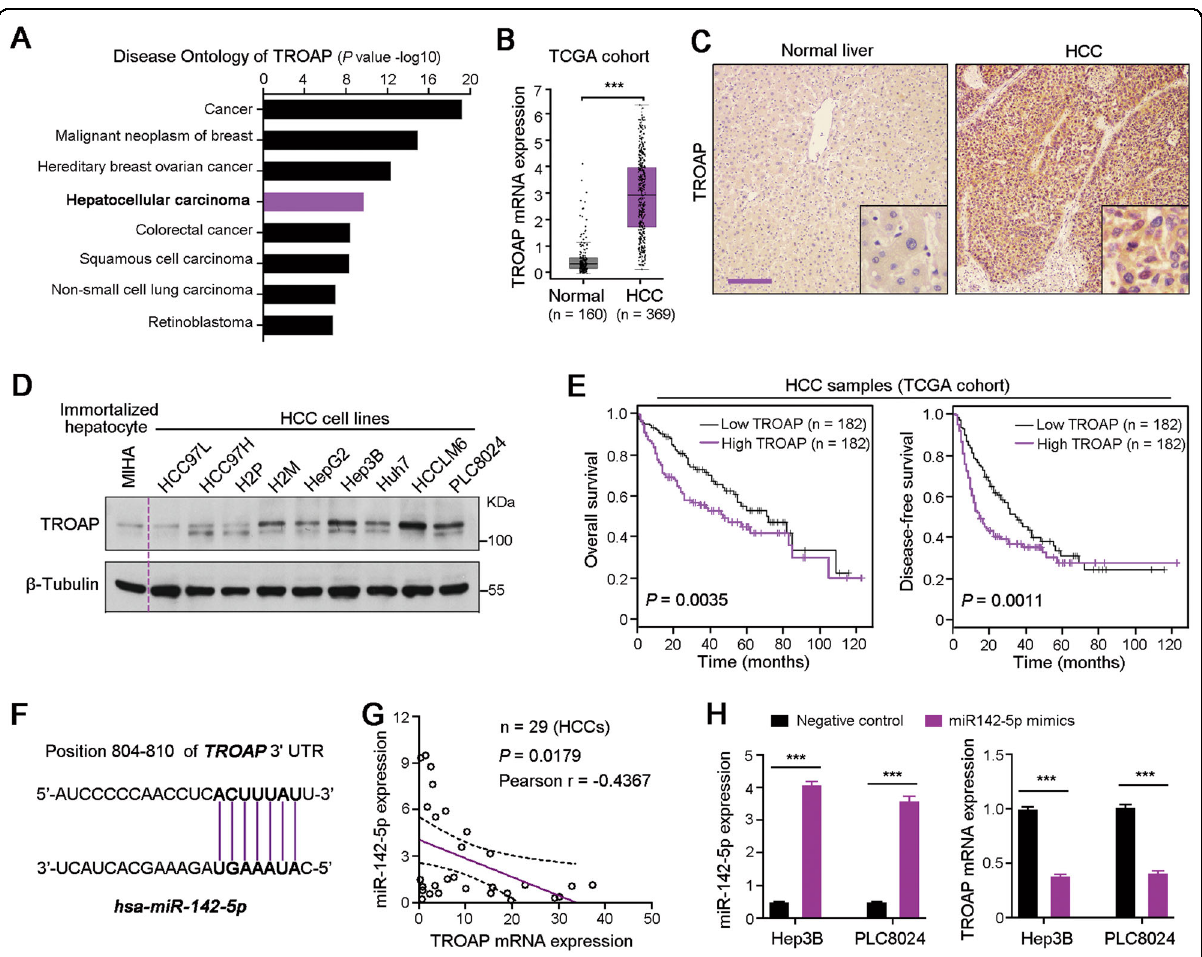
Fig. 7 Upregulated TROAP predicts the poor outcome of HCC patients. A Disease Ontology analysis of TROAP in human using Coexpedia internet tool (http://www.coexpedia.org/). B TROAP mRNA expression level in normal liver and HCC tissues was analyzed based on The Cancer Genome Atlas (TCGA) cohort. Two-sided Student ’ s t -test; *** P < 0.001. C IHC staining of TROAP in paired normal liver and HCC tissues. Scale bar, 200 μ m. D Western blotting analysis of TROAP expression in one immortalized liver cell line MIHA and nine HCC cell lines. β -Tubulin was used a loading control. E Kaplan – Meier survival curves based on TCGA database suggested that both overall survival and disease-free survival of the HCC patients with high TROAP expression were signi fi cantly shorter than those with low level of TROAP (Log-Rank test). F In human, miR-142-5p potentially targets the 3 ’ untranslated Region (UTR) of TROAP. G The expression correlation of miR-142-5p and TROAP in 28 HCC cases was analyzed by quantitative real-time PCR (qRT-PCR). H TROAP mRNA expression in Hep3B and PLC8024 cells was tested by qRT-PCR after transfection of miR-142- 5p mimics and negative control oligonucleotides. Data are represented as mean ± SEM; two-sided Student ’ s t -test; *** P <